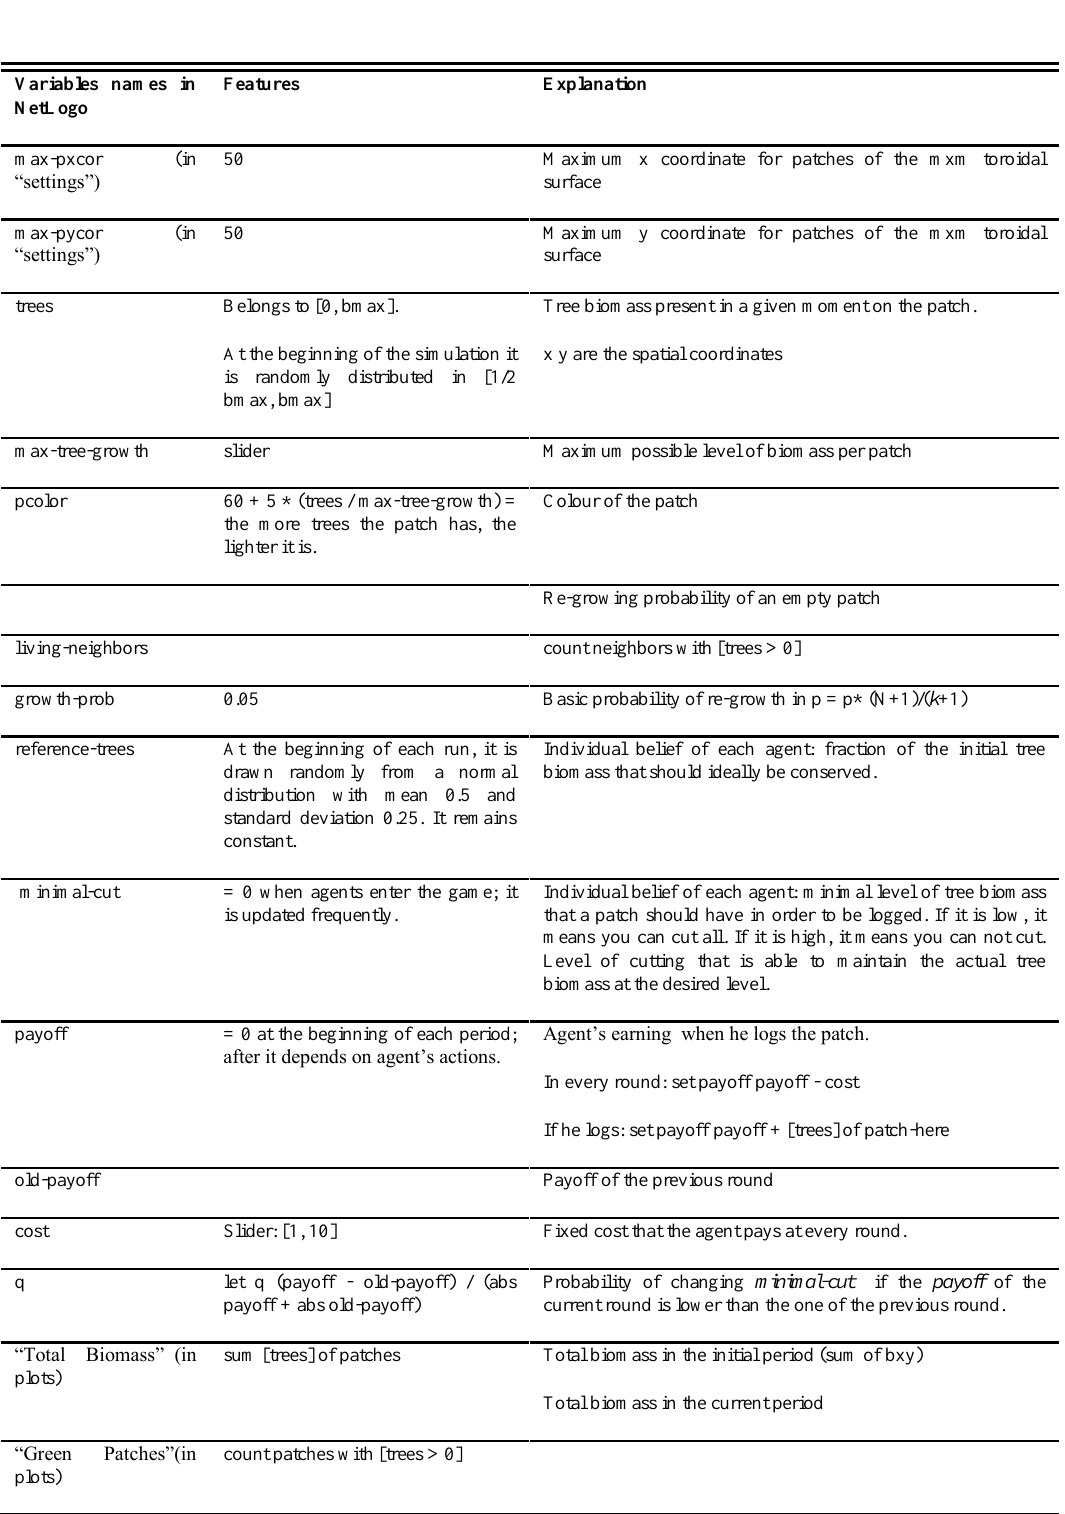
Table A.1. Variables used in the simulation in